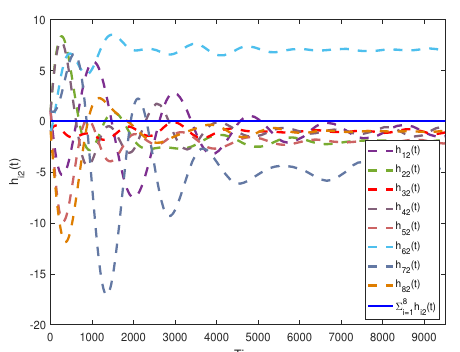
Figure 14. The trajectories of h i 2 ( t ) .